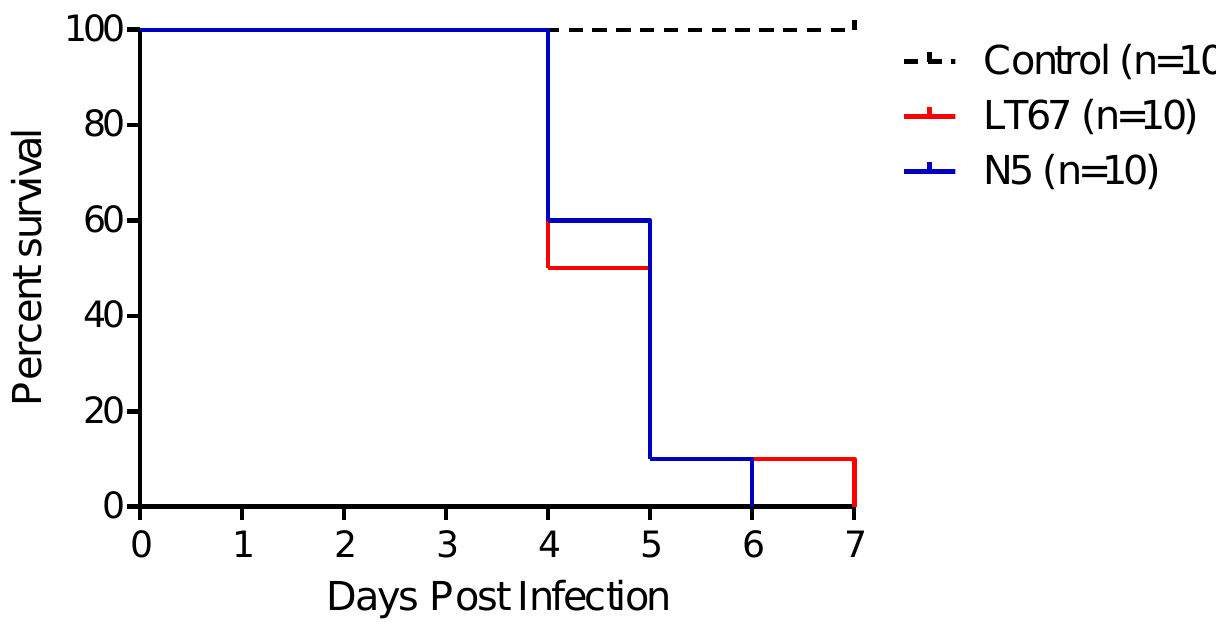
Figure 3. Survival curve in 35-days-old chickens experimentally inoculated with Newcastle disease virus isolates N5 and LT67.